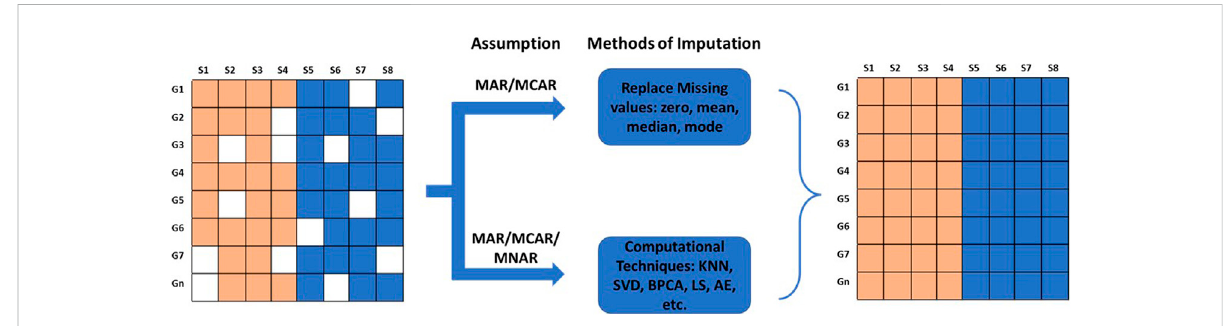
FIGURE 3 Typesofmissingdataandmethodsofimputationformissingvalues.ThemissingvaluescanbeMissingCompletelyAtRandom(MCAR),Missing At Random (MAR), or Missing Not At Random (MNAR). The missing values are imputed by fi xed values; by mean, mode, or median; or by values estimated using advanced computational